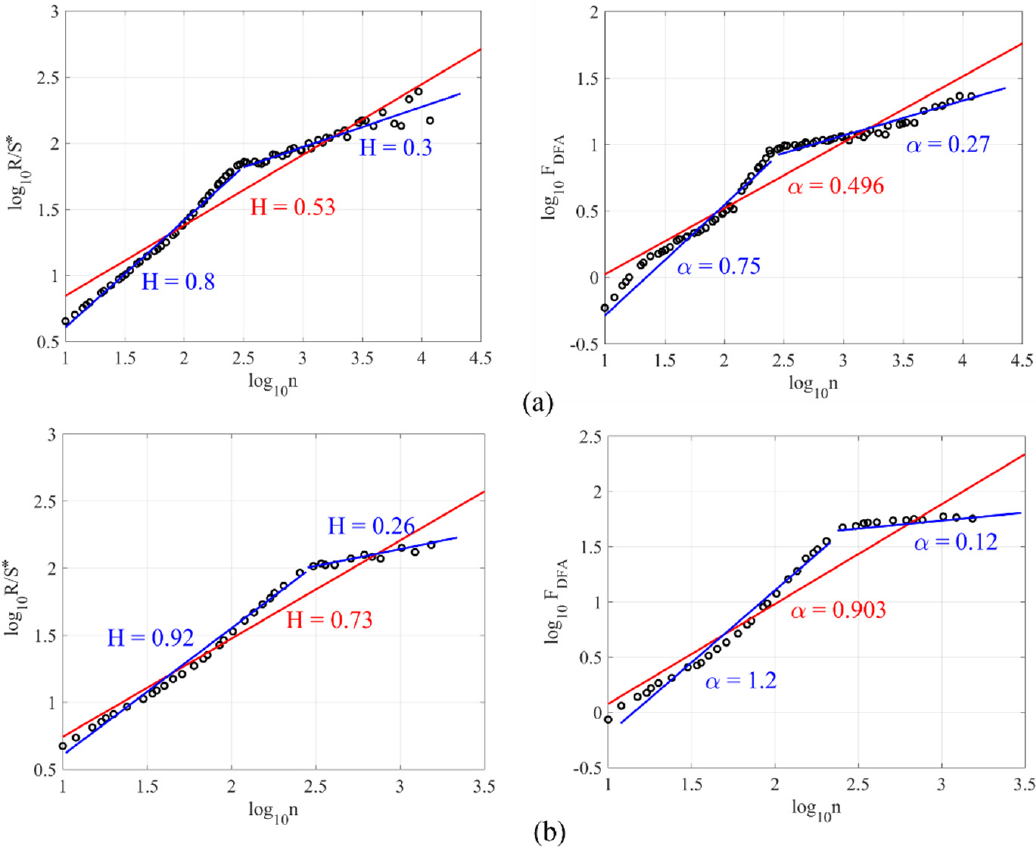
Figure 8. Details of the Hurst and DFA exponents for ( a ) signal at normalized time 0.24; ( b ) signal at normalized time 0.82.